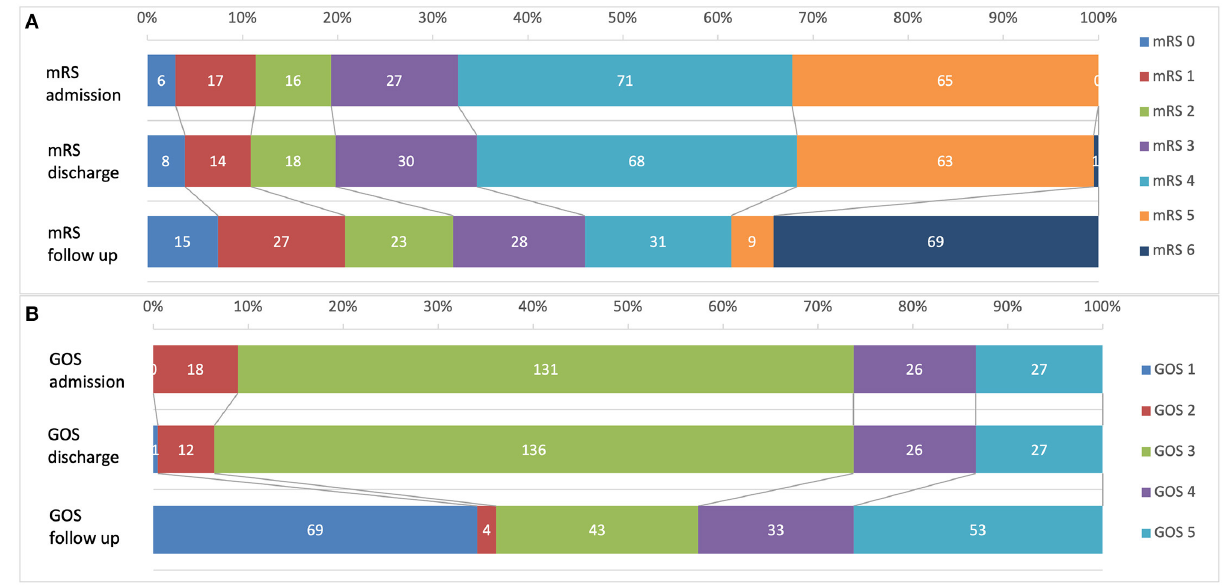
FIGURE 2 | Neurological outcome of 202 CP patients before surgery, after surgery and during a mean follow-up of 91.9 month. (A) Modified Ranking scale (mRS); (B) Glasgow Outcome Scale